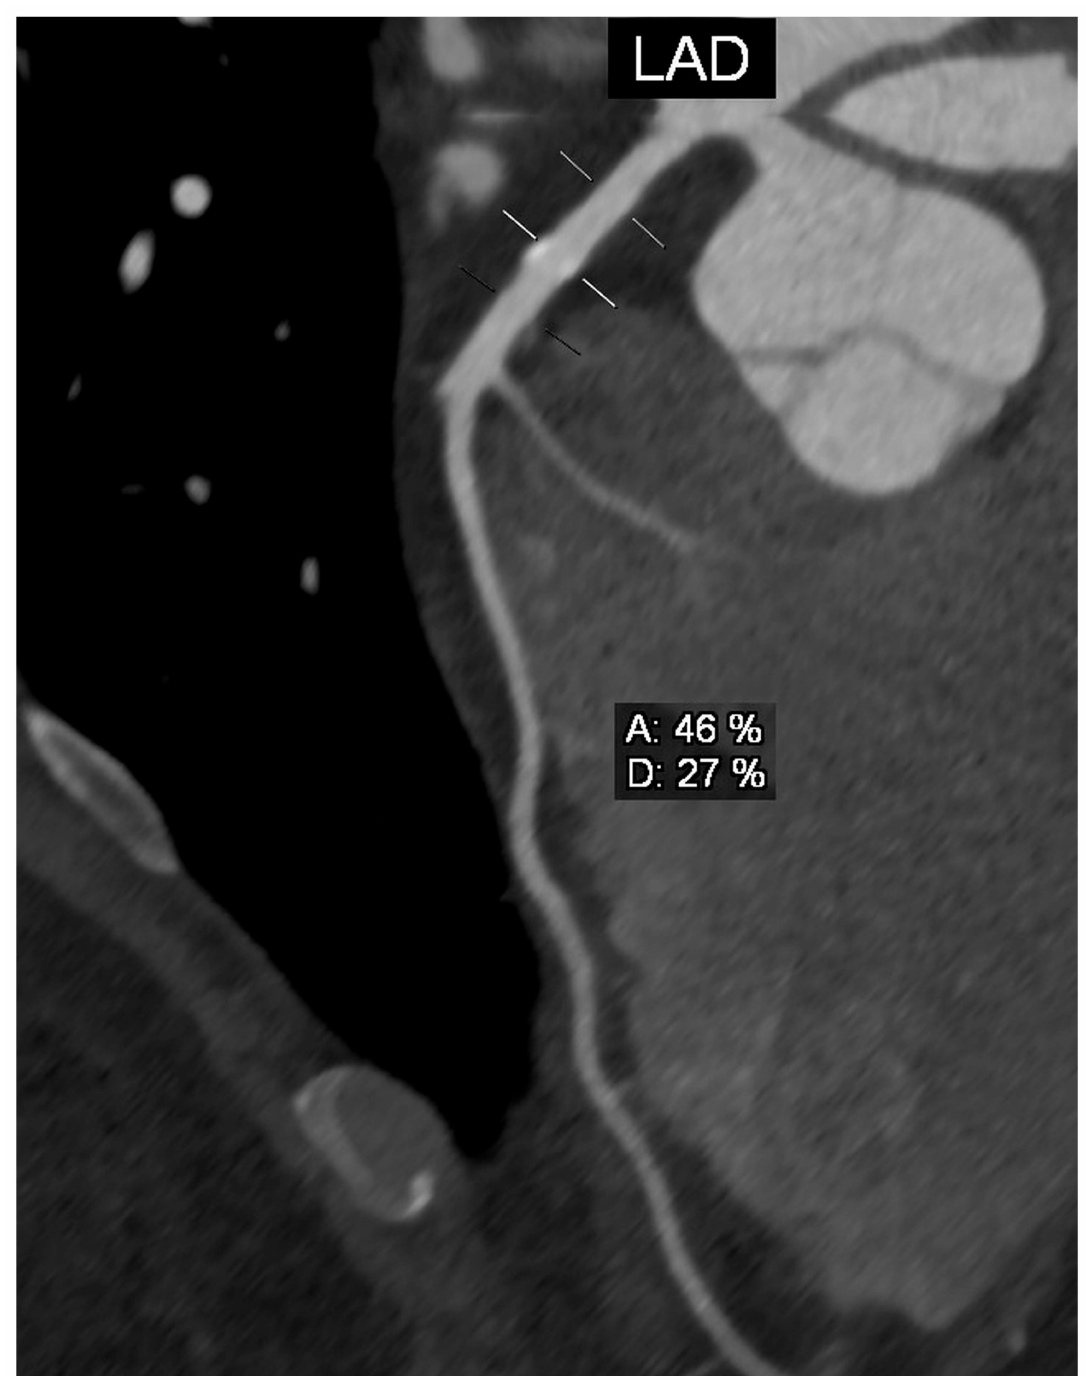
Figure 3. Cardiac computed tomography angiography. Angiographic phase. Curved planar re- construction (CPR). Left anterior descending (LAD) artery—short-section stenosis of the vessel by 25–50%. Three lines on the course of the vessel: a reference line above the stenosis, a line at the level of the stenosis and a reference line below the stenosis. A—% of stenosis calculated based on the perpendicular cross-sectional area of the vessel, D—% of stenosis calculated based on of the diameter of the